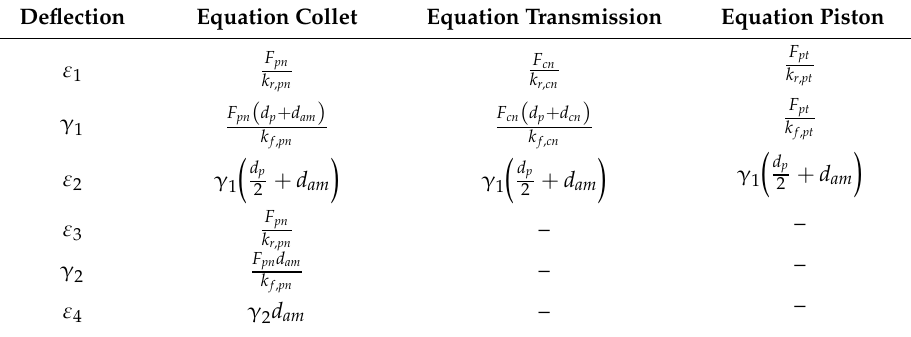
Figure 12. Centrifugal forces and distances at clamping position. Table 3. Deflections of collet chuck due to centrifugal